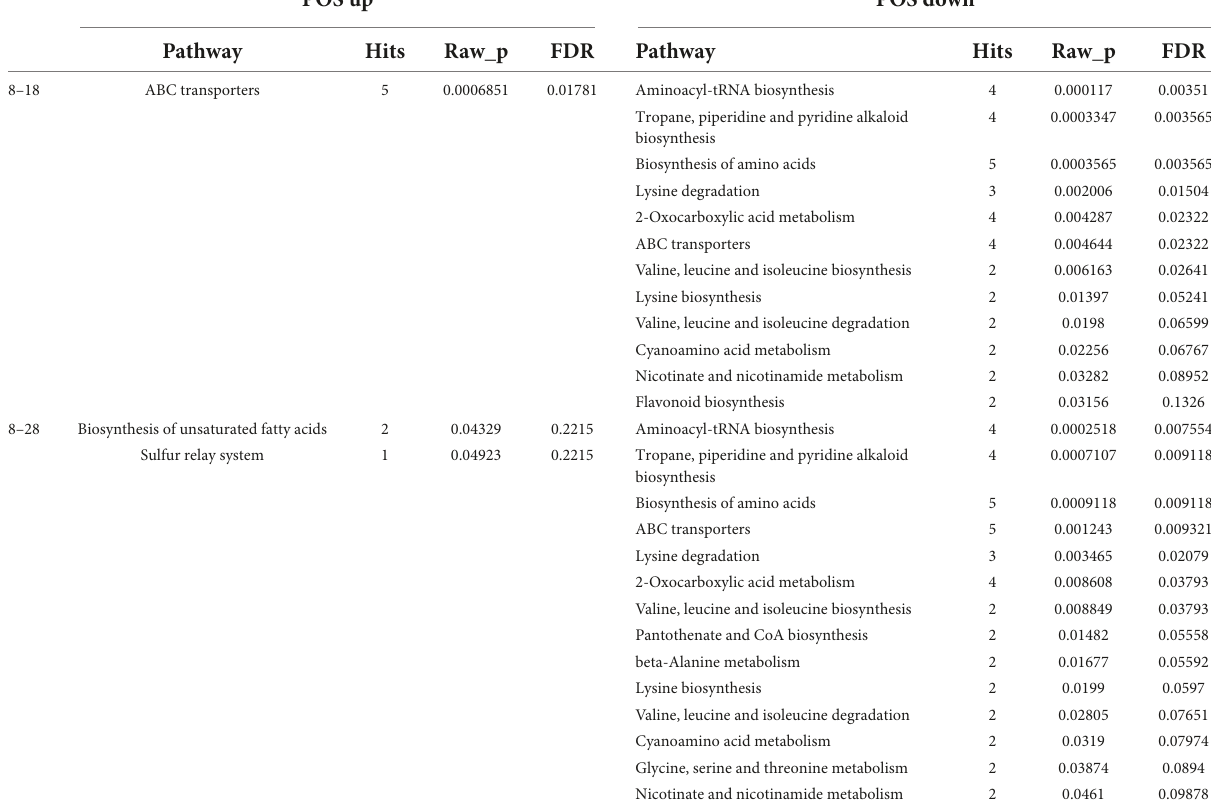
TABLE 1 Positive analysis significant enrichment of KEGG pathway.